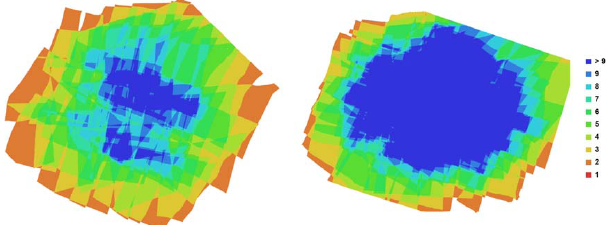
Figure 2. Camera images and their overlaps during each of the two surveys. The left panel corresponds to the survey made dur- ing September 2013, while the right panel corresponds to the sur- vey made in April 2014. The legend indicates the number of images covering each